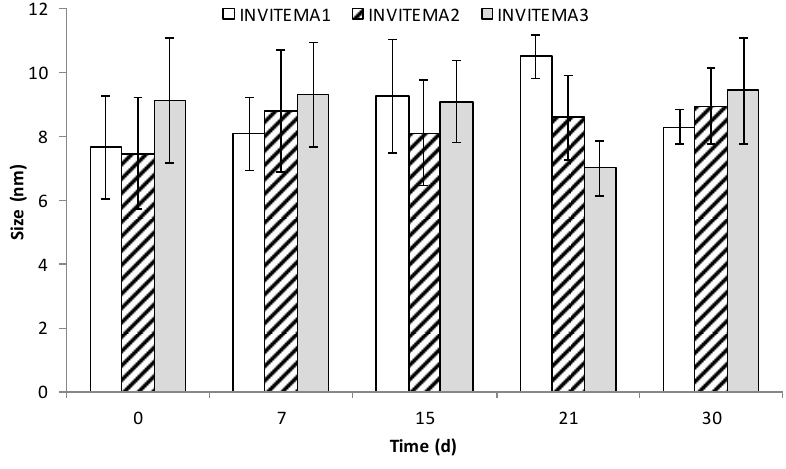
Figure 4. Size distribution and stability studies of INVITEMA 1, 2 and 3 micelles up to 30 days in ultrapure water by DLS.